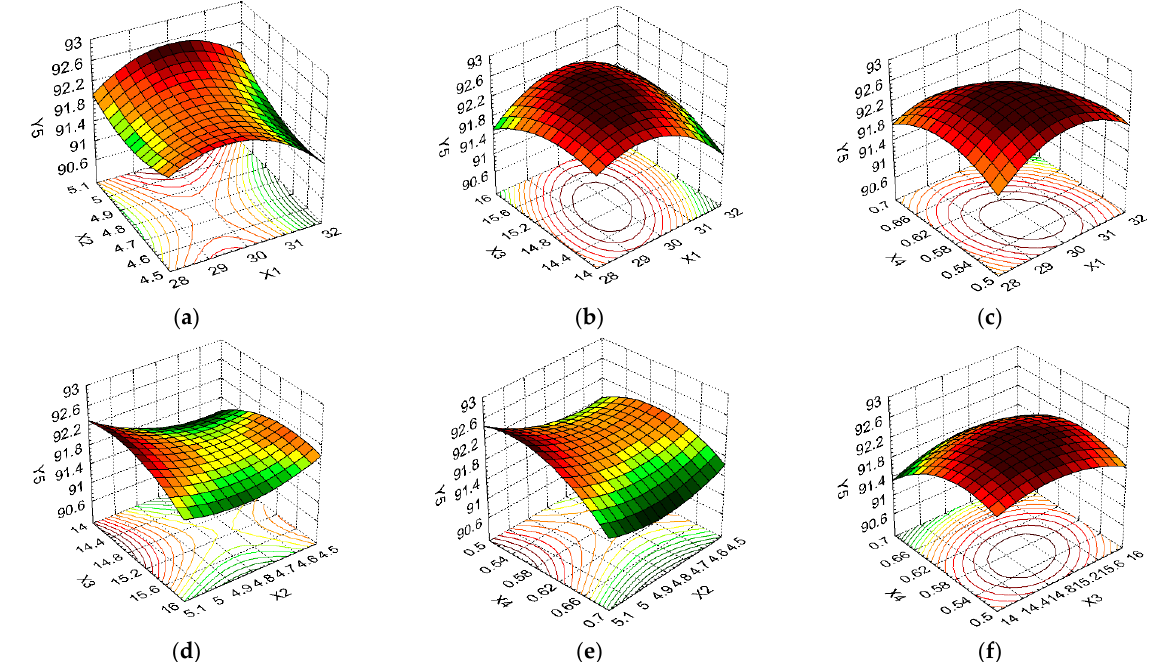
Figure 9. 3D response surface and contour plot showing the effects of different cultivation conditions on the response regarding dry matter content (Y 5 ): ( a ) temperature (X 1 ) and pH (X 2 ); ( b ) temperature (X 1 ) and carbon source (X 3 ); ( c ) tem- perature (X 1 ) and nitrogen source (X 4 ); ( d ) pH (X 2 ) and carbon source (X 3 ); ( e ) pH (X 2 ) and nitrogen source (X 4 ); and ( f ) carbon source (X 3 ) and nitrogen source (X 4 ).